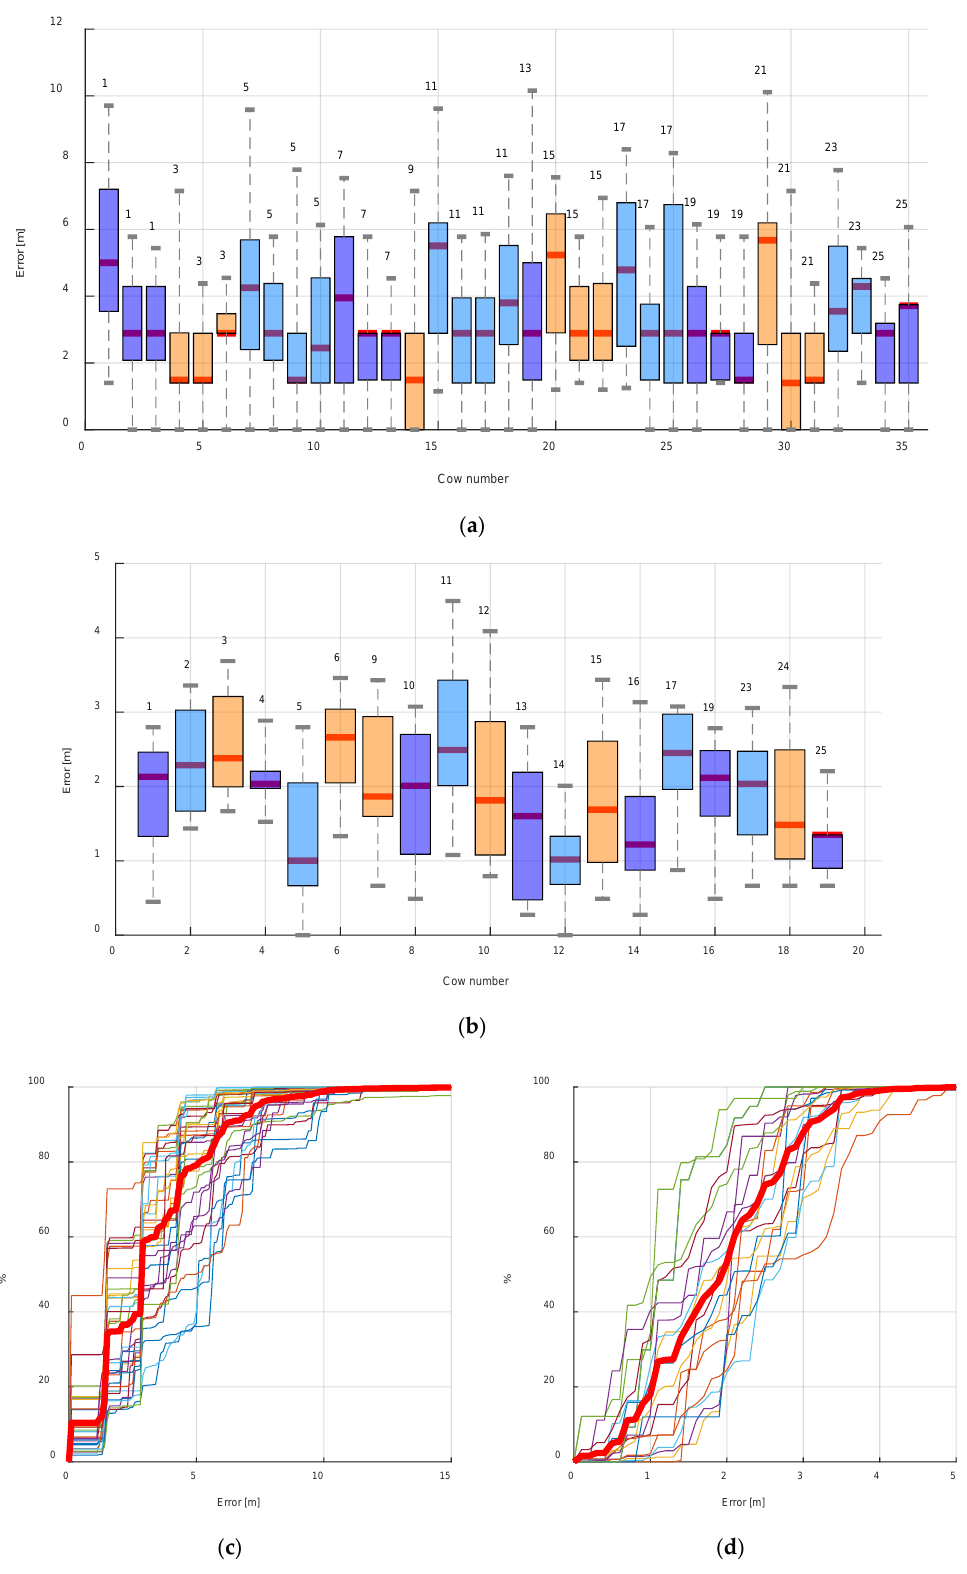
Figure 12. Total localization accuracy represented by the boxplot for each cow and tags (signed above the boxplot) and average cumulative accuracy for the entire barn ( a ) and ( c ) and waiting yard ( b ) and the experiments ( d